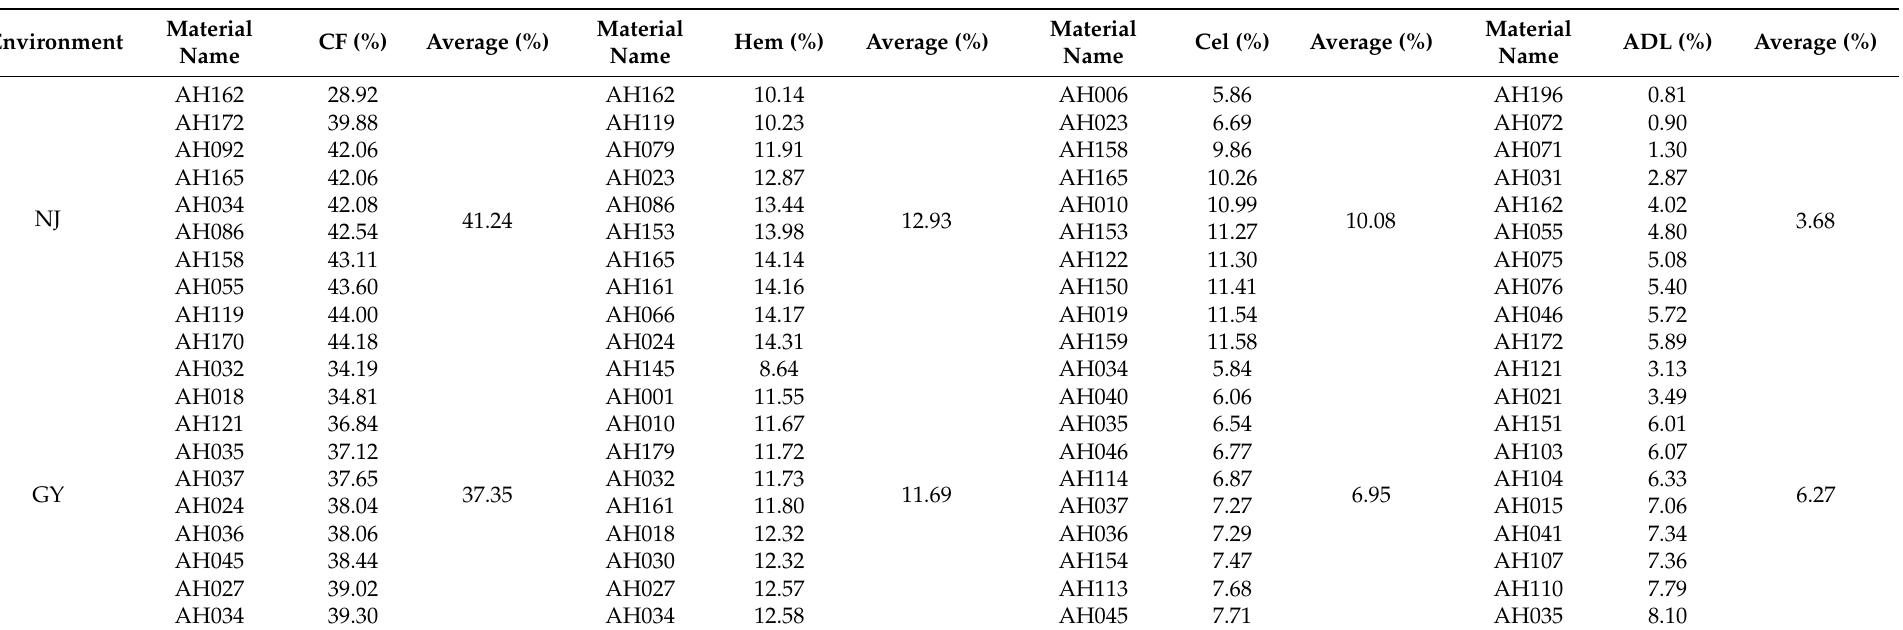
Table 5. The top ten lines of B. napus shoots with the lowest crude fiber component content in different